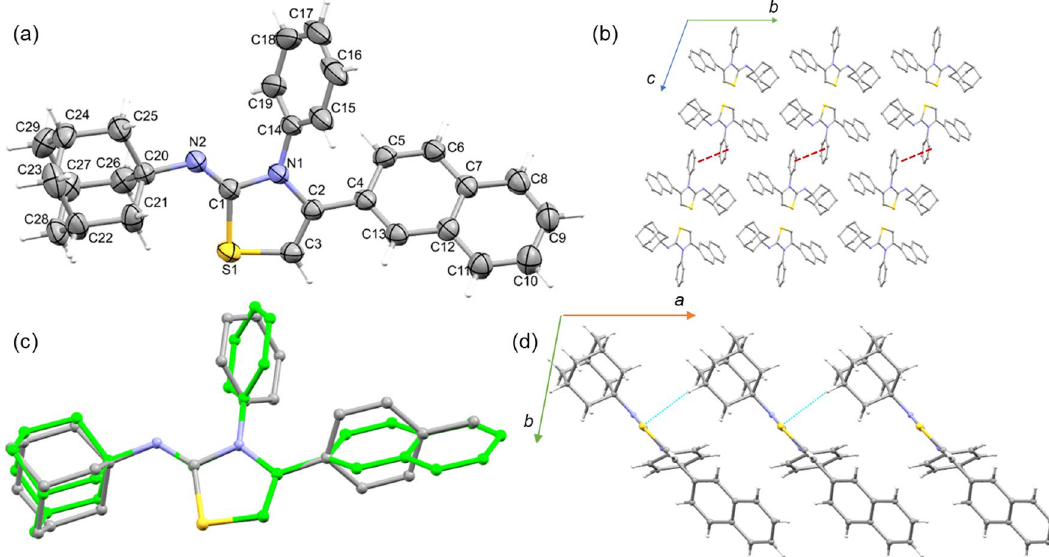
Figure 6. ( a ) ORTEP representation of compound 5f. with atom-labelling scheme, ( b ) crystal packing of compound 5f. projected along bc plane and the π-stacking interaction between phenyl rings is shown as red dashed lines, ( c ) structural superposition of compounds 5d and 5f. (cyclohexane solvent has been omitted for clarity) and ( d ) molecular chain is generated via a weak intermolecular C–H…S